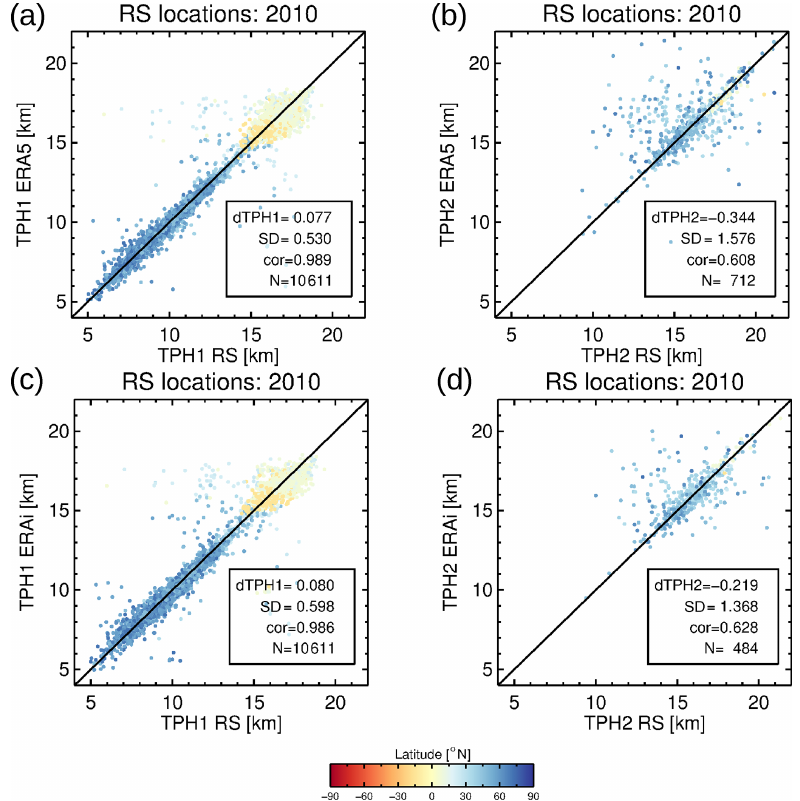
Figure 17. Correlation diagram of HVRRD first (a, c) and second (b, d) tropopause heights versus ERA5 (a, b) and ERA-Interim (c, d) tropopause heights for the 2010 radiosonde (RS) locations,